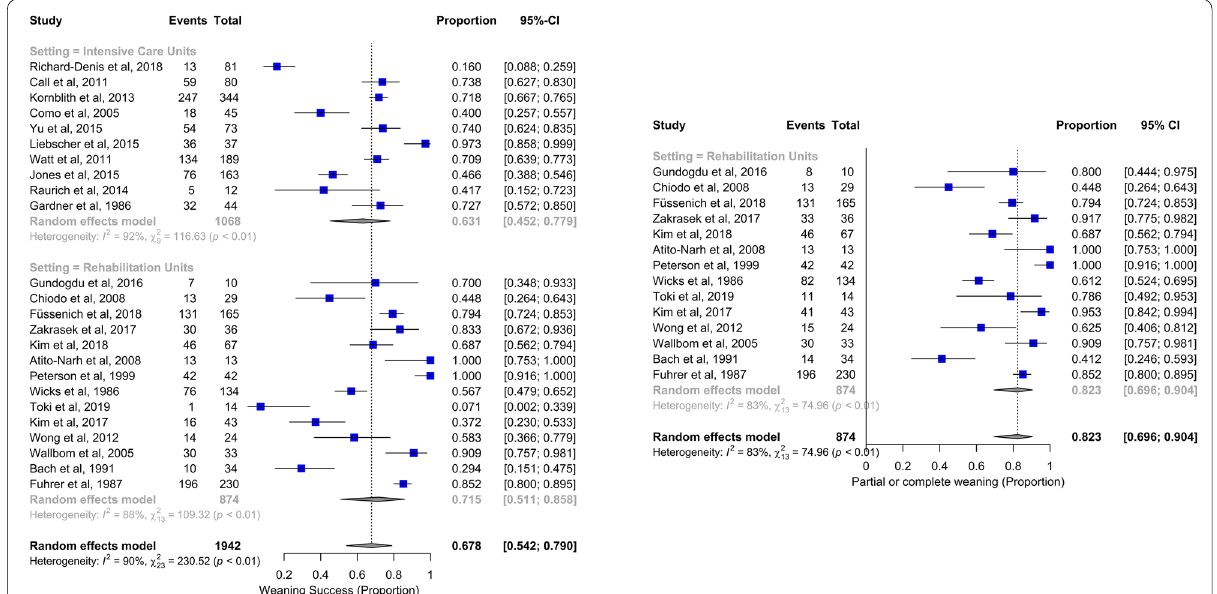
Fig. 2 Forest plots for the outcome of complete liberation from the ventilator (left panel) and for the outcome of partial or complete weaning after rehabilitation (right panel). Studies are presented according to setting classification (intensive care units vs rehabilitation units): both overall and subgroup estimates are reported. Number of events and total number of patients at risk are reported for each study. The computation process has been described in the Methods. CI: confidence